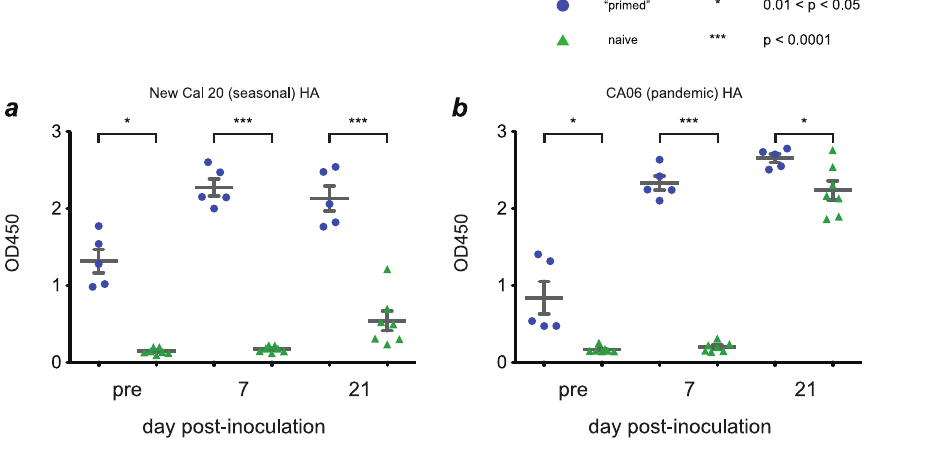
Figure 6. Infection with seasonal influenza viruses induces variable levels of antibody capable of binding H1N1pdm antigens. We used purified hemagglutinin (HA) proteins to capture antibodies from macaque serum. Antibodies were detected using an anti-IgG antibody coupled to horseradish peroxidase, with enzymatic activity quantified using a colorimetric assay. Results are expressed in terms of sample absorbance at 450 nm. Antigens used in each assay were as follows: a , Purified HA protein from A/New Caledonia/20/1999, a close antigenic match to K173. b , Purified HA from A/California/06/2009, a close antigenic match to CA04. Assays using lysates of K173 or CA04 viruses gave similar results (data not shown).